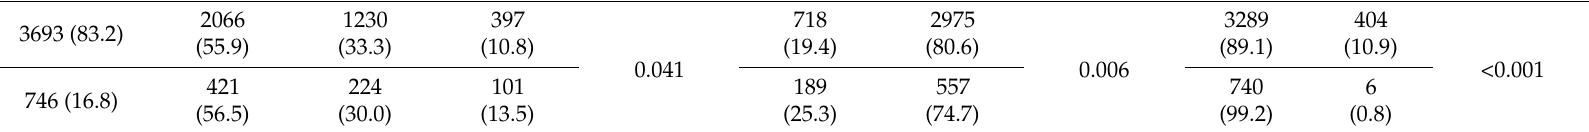
Table 1. Factors associated with financial insecurity, decrease in food intake and impact of the pandemic on daily life of adults living in Nigeria during the COVID-19 pandemic ( N = 4439). Financial Insecurity Decrease in Food Intake Variables Total n (%)